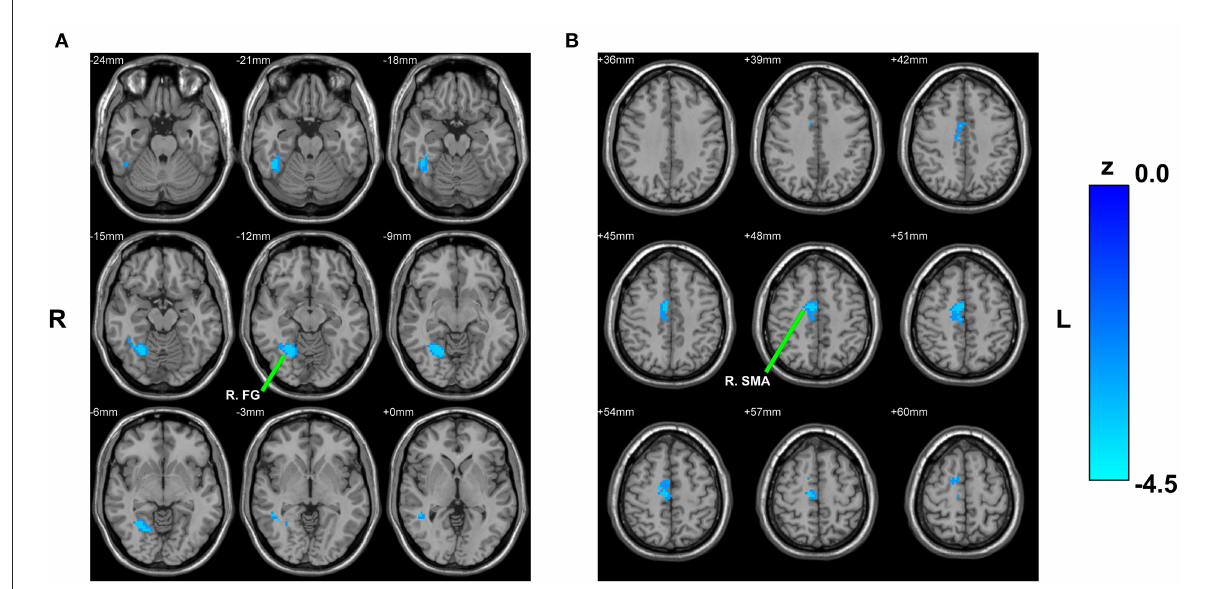
FIGURE3 Between-group comparison based on the left cHipp. The decreased RSFC of the left cHipp with right fusiform gyrus (A) and right supplementary motor area (B) in children with PNE, respectively. cHipp, caudal hippocampus; PNE, primary nocturnal enuresis; R. FG, right fusiform gyrus; R. SMA, right supplementary motor area; color bar, z value.